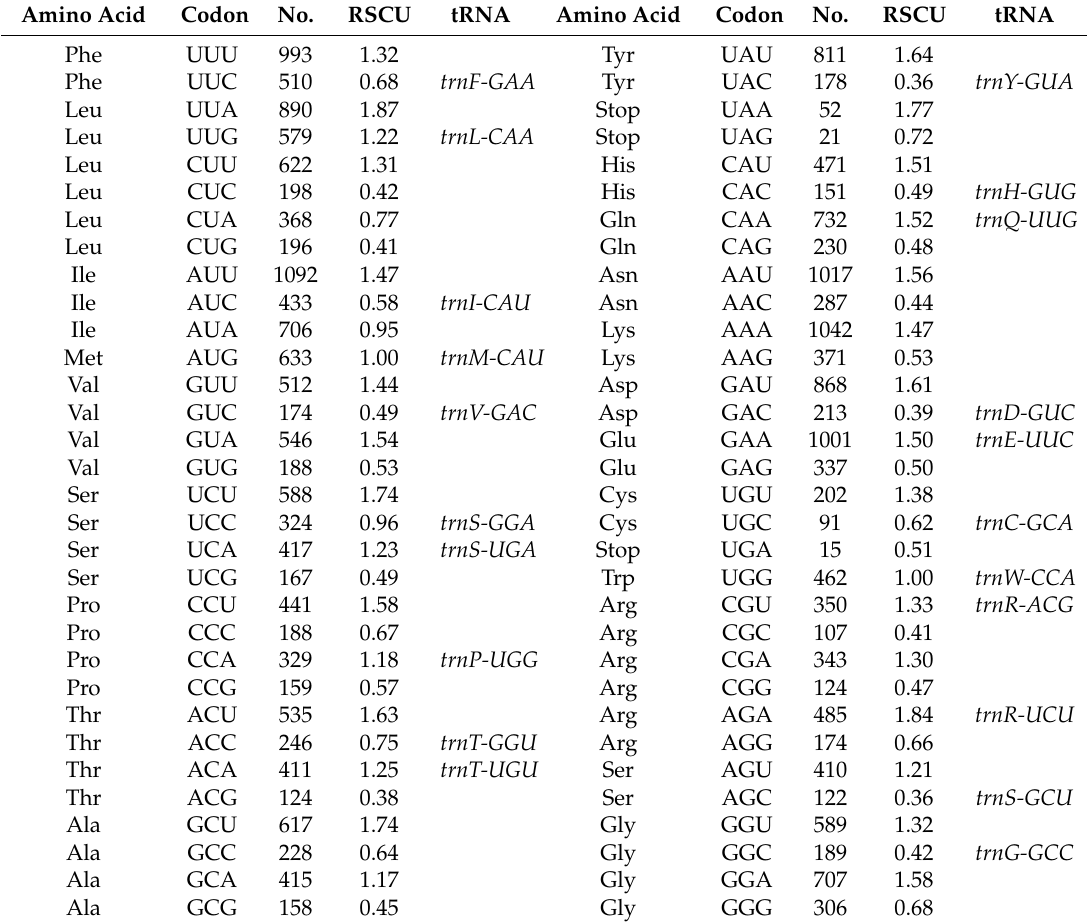
Table 2. Codon-anticodon recognition patterns and codon usage of the A. annua chloroplast genome. Amino Acid